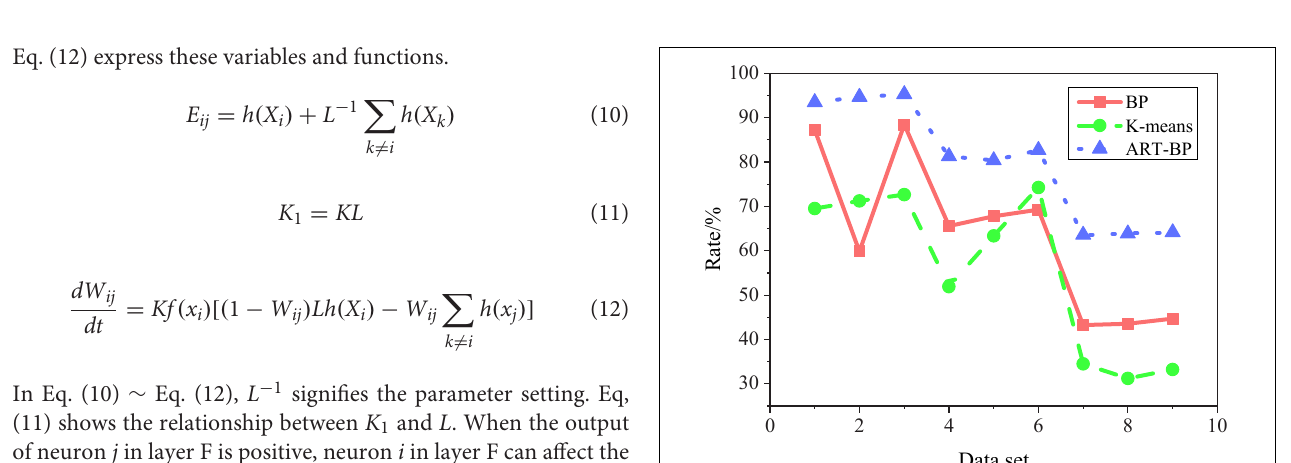
FIGURE 6 | Use of education policy (EP) tools for migrant children (MC). (A) Quantity chart of different policy tools; (B) proportion chart of different policy tools.